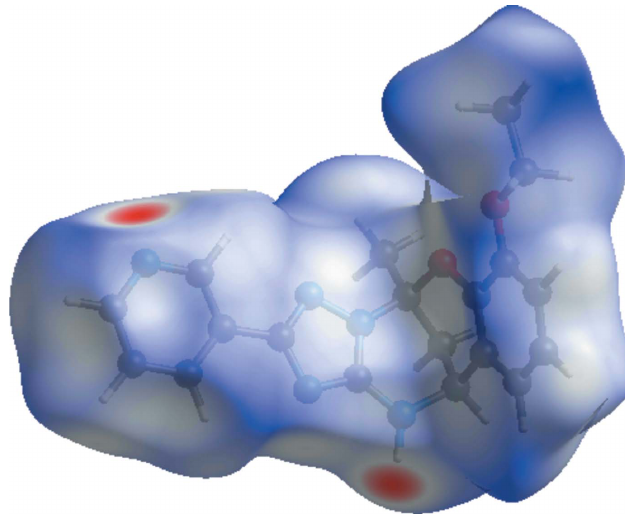
Figure 3 The Hirshfeld surface of C 19 H 19 N 5 O 2 mapped with d norm